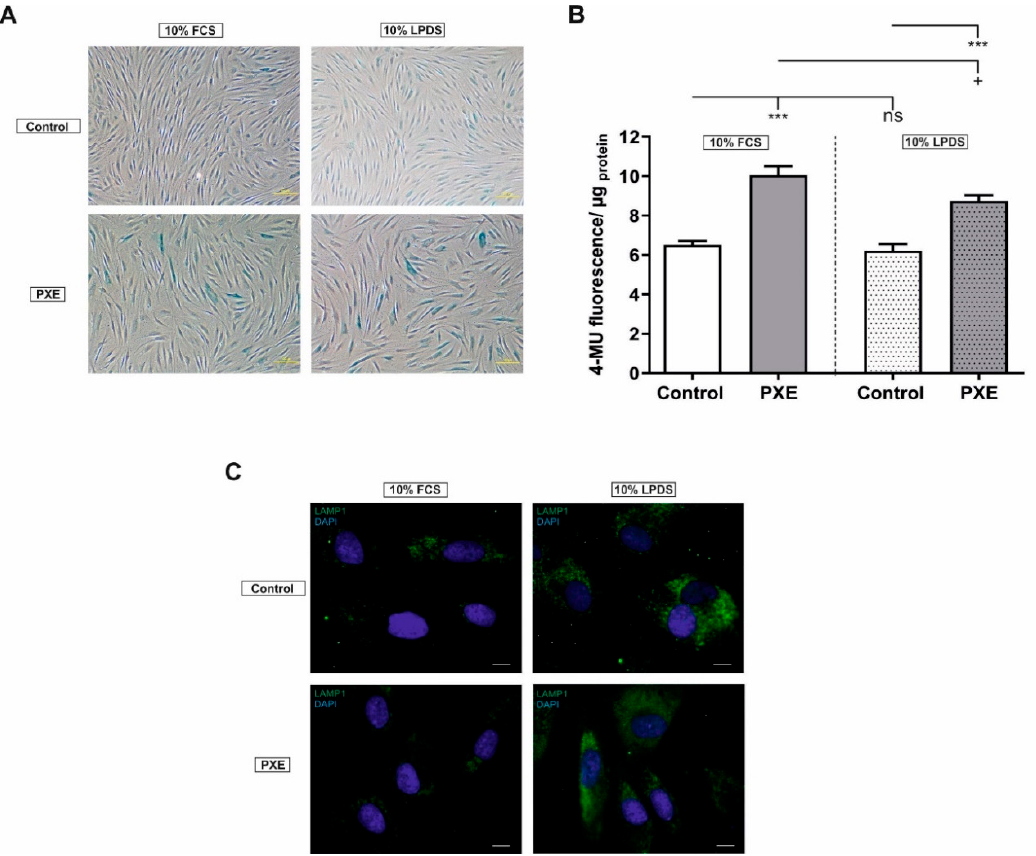
Figure 1. SA- β -Gal activity and immunofluorescence microscopy of LAMP1 for pseudoxanthoma elasticum (PXE) fibroblasts and normal human dermal fibroblasts (NHDF). Fibroblasts were cultivated for 72 h in medium with 10% fetal calf serum (FCS) or 10% lipoprotein-deficient fetal calf serum (LPDS). ( A ) Qualitative senescence assay for PXE fibroblasts ( n = 3) and NHDF ( n = 3). Representative images are shown. Scale bar: 100 μ m. ( B ) Quantitative senescence assay for PXE fibroblasts (gray, n = 3) and NHDF (white, n = 3). Data are shown as mean ± SEM. Control/ PXE: *** p ≤ 0.001. 10% FCS / 10% LPDS: + p ≤ 0.05; ns p > 0.05. ( C ) Immunofluorescence microscopy of LAMP1 (green) for PXE fibroblasts ( n = 3) and NHDF ( n = 3). Cell nuclei were counterstained with DAPI (blue). Representative images are shown. Scale bar: 10 μ m.